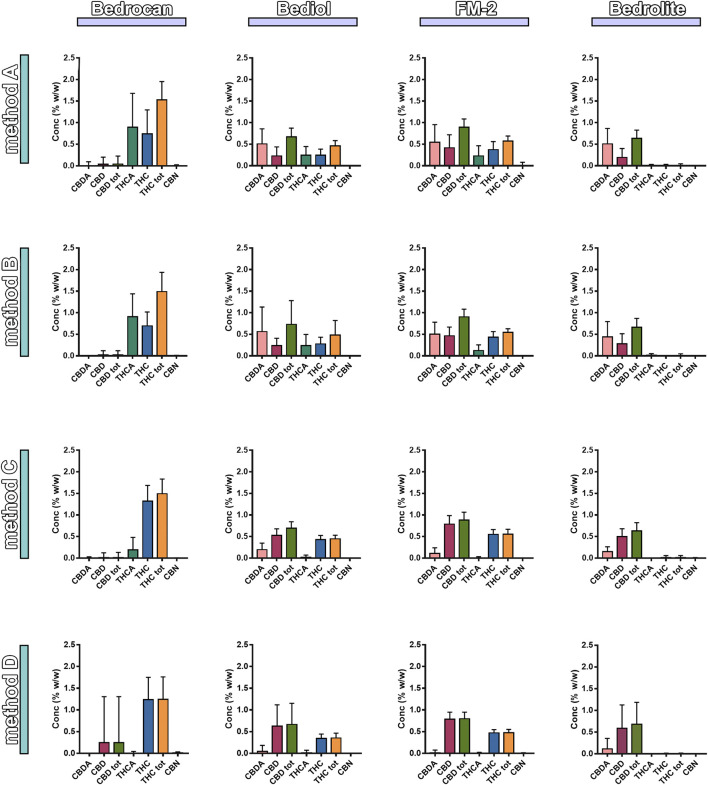
Distribution of phytocannabinoids among extraction methods from plant materials and varieties (4,774, mean ± SD). The columns represented the cannabis sativa varieties (sx to dx) Bedrocan, Bediol, FM2, and Bedrolite and the rows the Method of extraction (up to down) [Method A (Romano and Hazekamp, 2013), Method B (Citti et al., 2016), Method C (Società Italiana Farmacisti Preparatori (SIFAP), 2016; Casiraghi et al., 2018), and Method D (Calvi et al., 2018)].